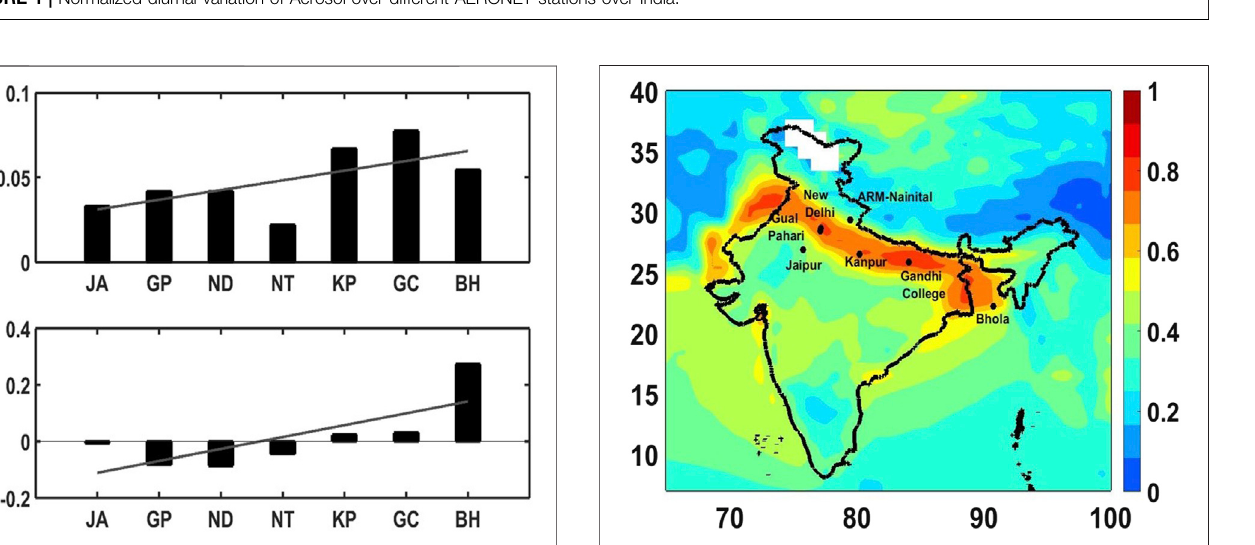
FIGURE 1 | Normalized diurnal variation of Aerosol over different AERONET stations over India.